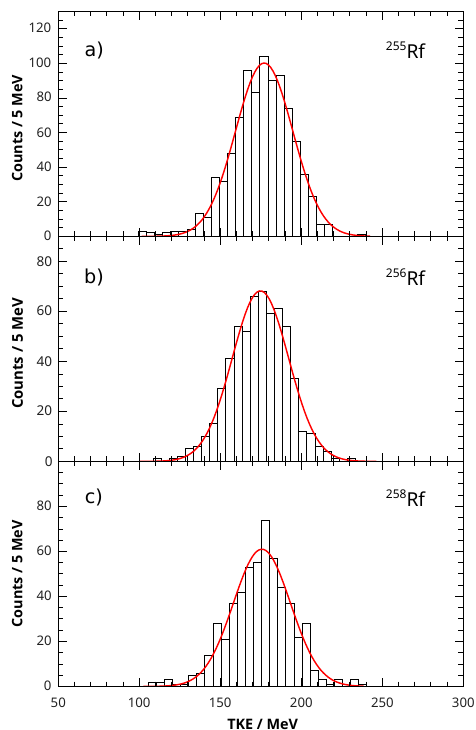
Figure 1. Total kinetic energies for 255 Rf, 256 Rf and 258 Rf from all observed SF events for each isotope. Due to the pulse-height defect, the positions of gaussians are shifted to lower values.